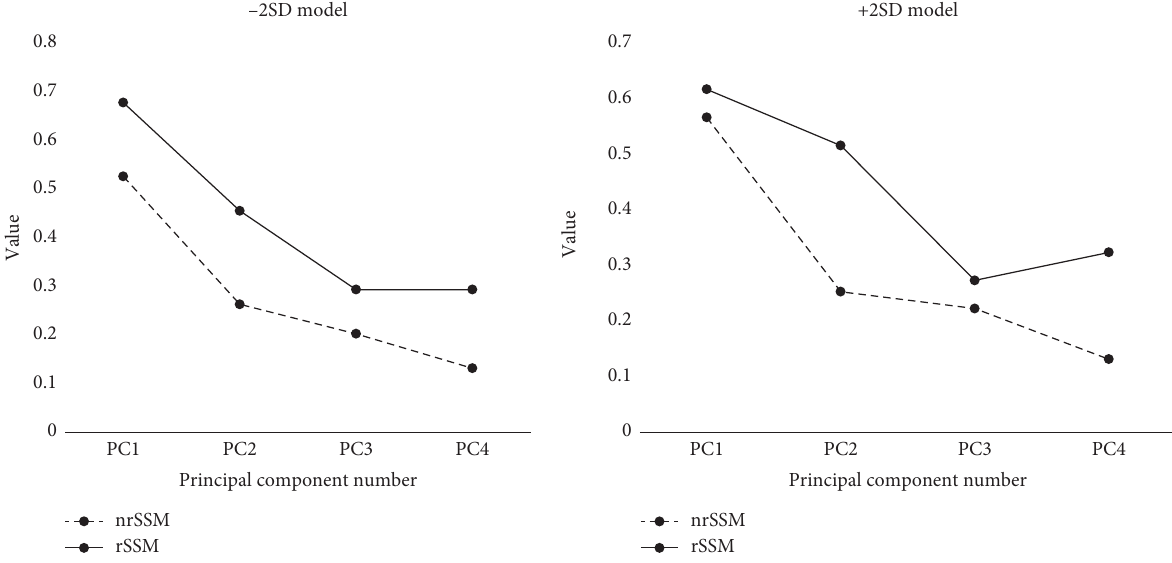
F IGURE 6: Gaussian curvature value between nonregion-based SSM and region-based